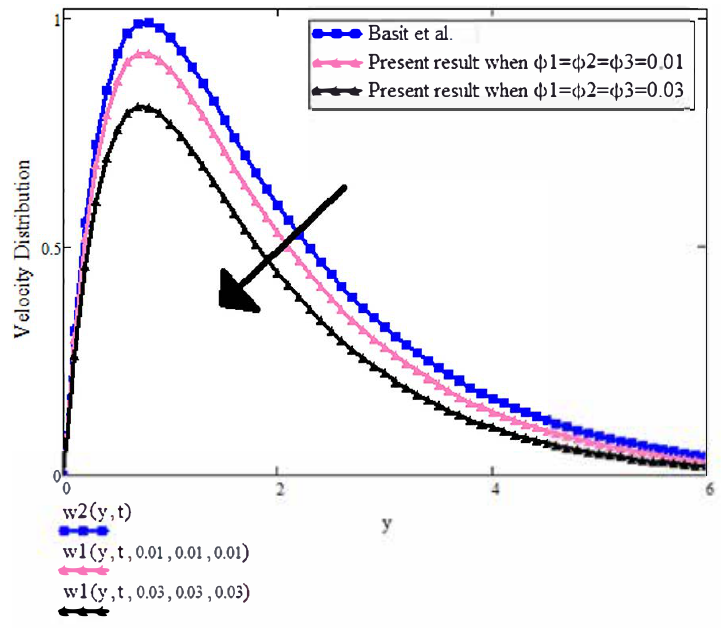
Figure 12. u ( y , t ) with φ 1 , φ 2 , φ 3 when t = 2, a = 0.1, λ = 0, Gr = 15, β 1 = 0.9